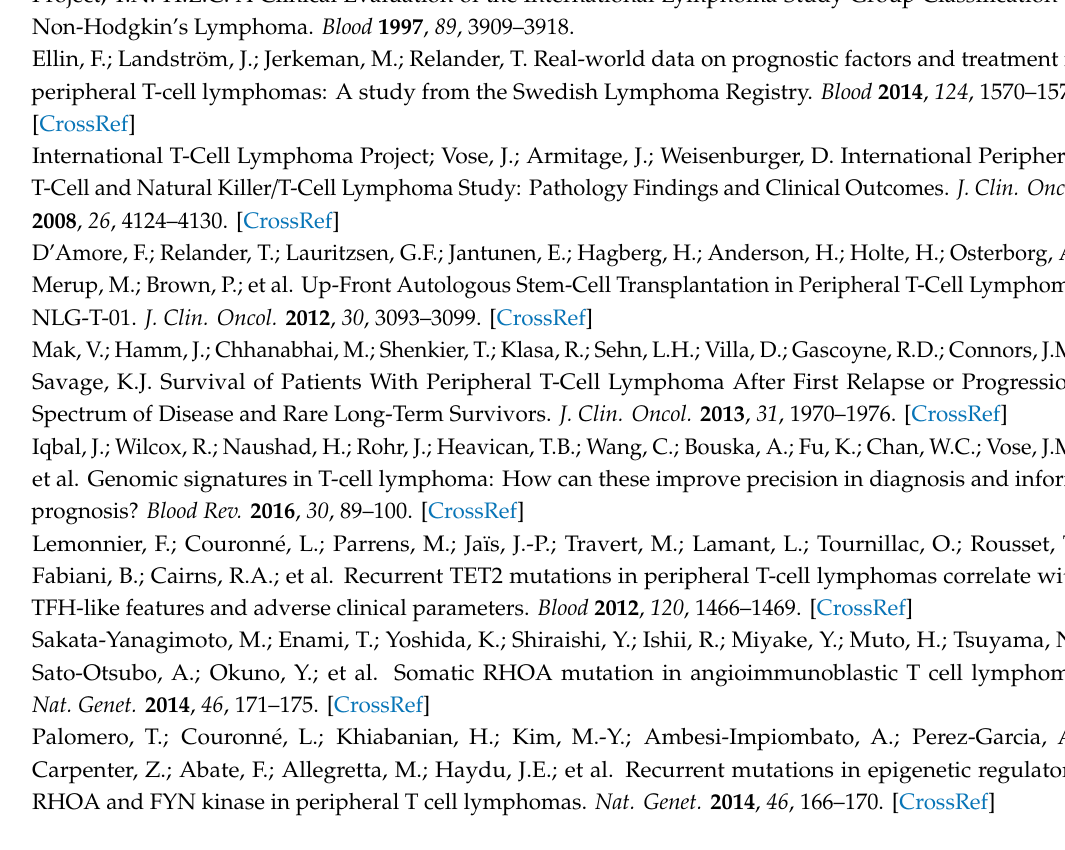
Figure S1: pMAPK, pAKT and pSTAT3 staining of PTCLs, Figure S2: STAT3 expression correlation with JAK1 , JAK3 , AKT and MAPK expression in T-cell neoplasia cell lines from the CCLE dataset, Figure S3: Association of STAT3, MAPK and AKT phosphorylation with CD30 phenotype and EBV status, Figure S4: Association of STAT3, MAPK and AKT phosphorylation with sample type and organ origin, Figure S5: Multiplex immunohistochemistry staining of pSTAT3 Tyr705 in CD8 + LGL-leukemia as a positive control stain for pSTAT3 antibody, Figure S6: Full western blot of p-STAT3 (Tyr705), STAT3, p-JAK3 (Tyr980 / 981), and JAK3 in T cell malignancy cell lines, Table S1: Cell lines and JAK / STAT mutation status, Table S2: Clinical and pathological characteristics of PTCL patients, Table S3: Locus-specific primers for STAT3 and STAT5B exons and RHOA G17V mutation hotspot, Table S4: Densitometry readings of Western blot